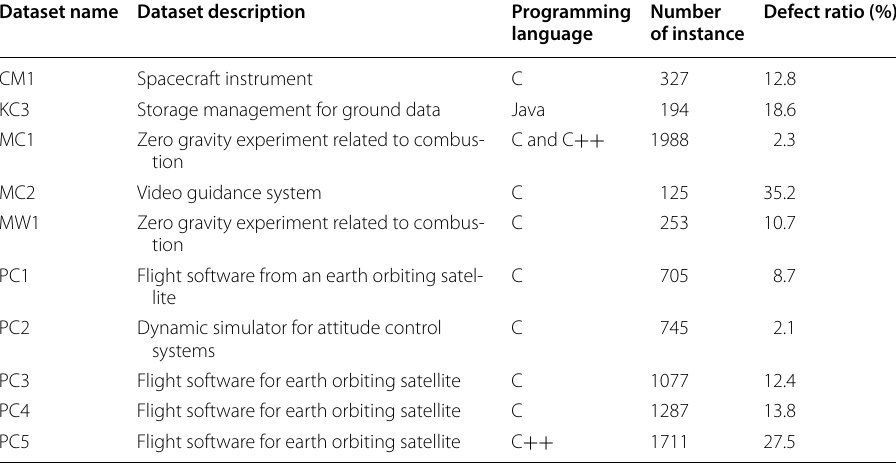
Table 1 NASA MDP